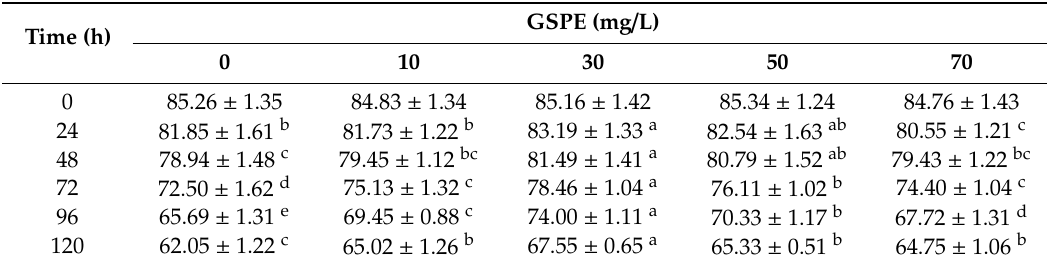
Table 3. E ff ect of grape seed procyanidin extracts (GSPE) on the acrosome integrity of goat sperm of preserved at 4 ◦ C (%).